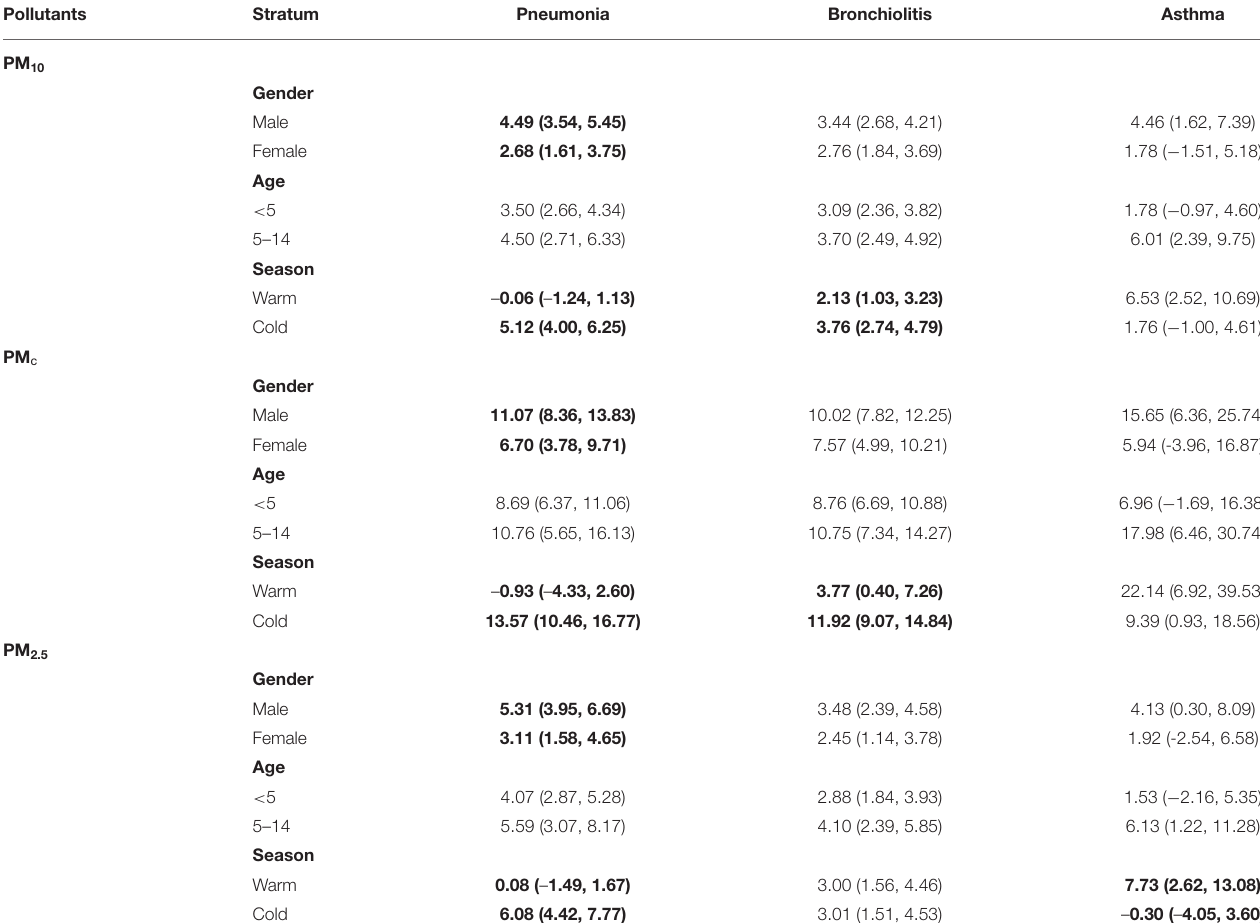
TABLE 3 | Excess risk and 95% CIs of pneumonia, bronchiolitis, and asthma for each 10 µ g/m 3 increase in PM 2.5 , PM c , and PM 10 stratified by gender, age group, and season. Pollutants Stratum